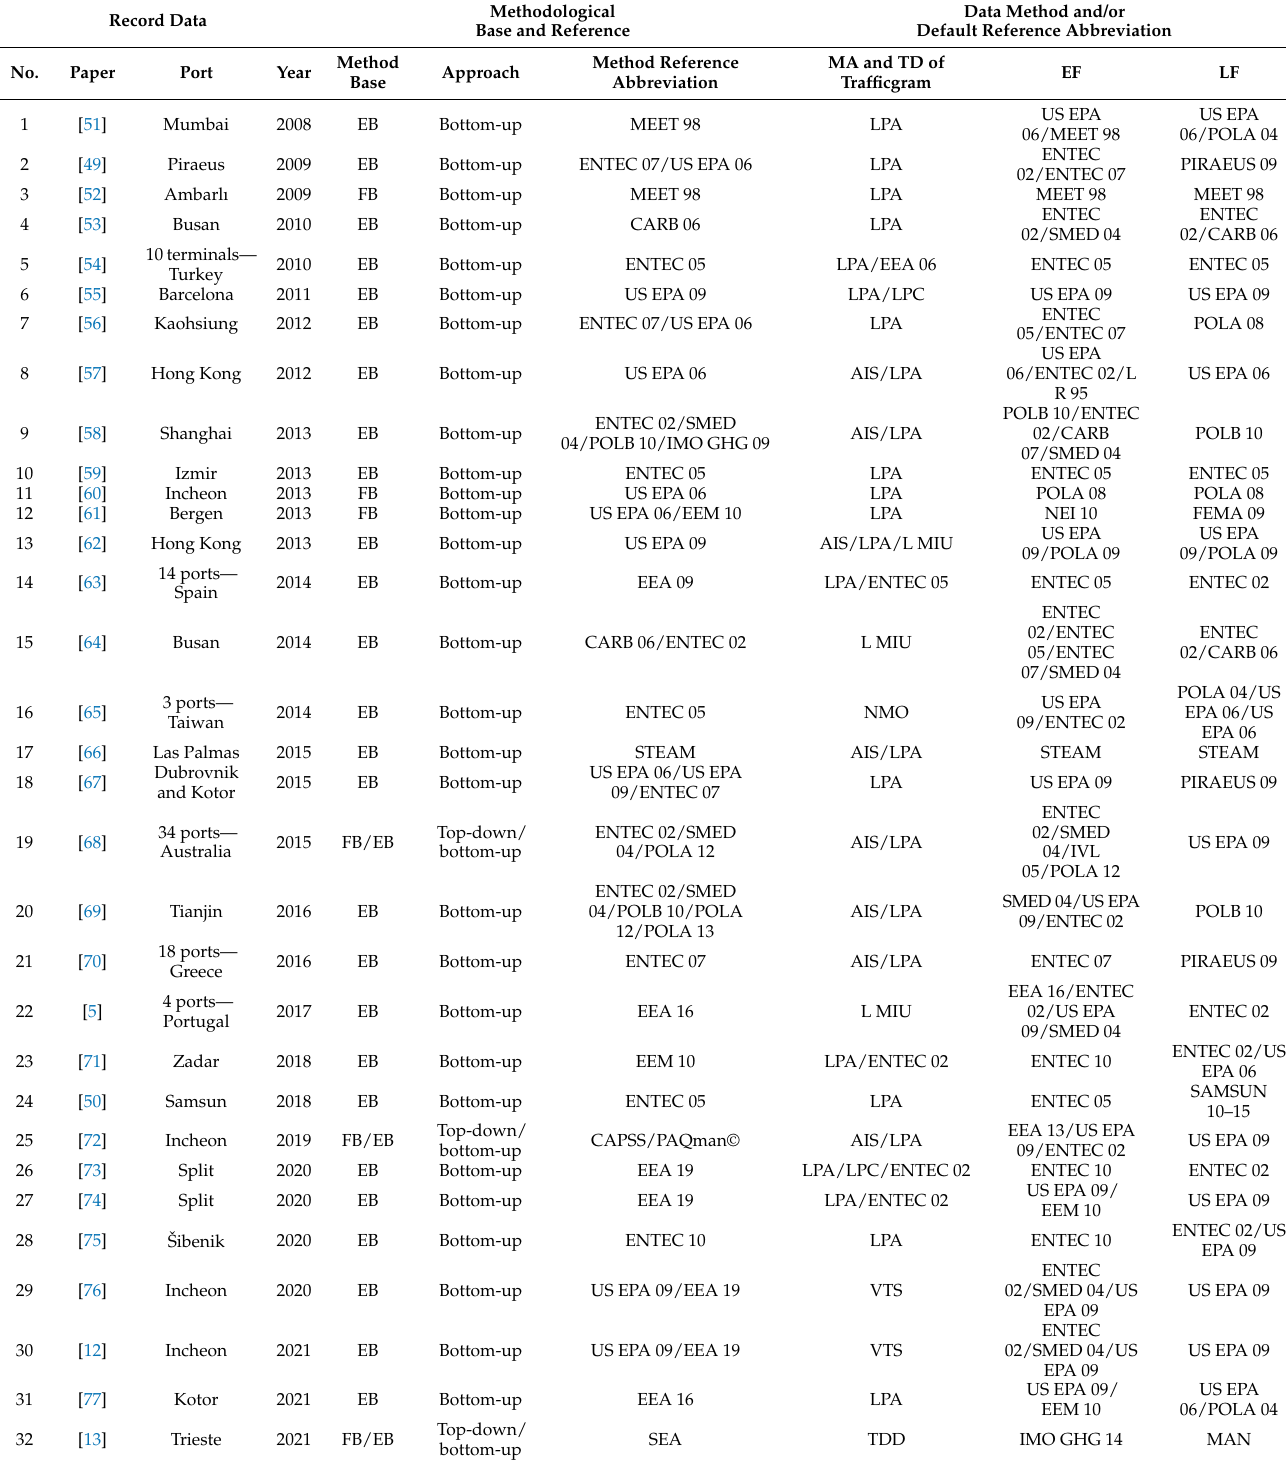
Table 2. Analytical overview of the literature that explores port-related ship emission